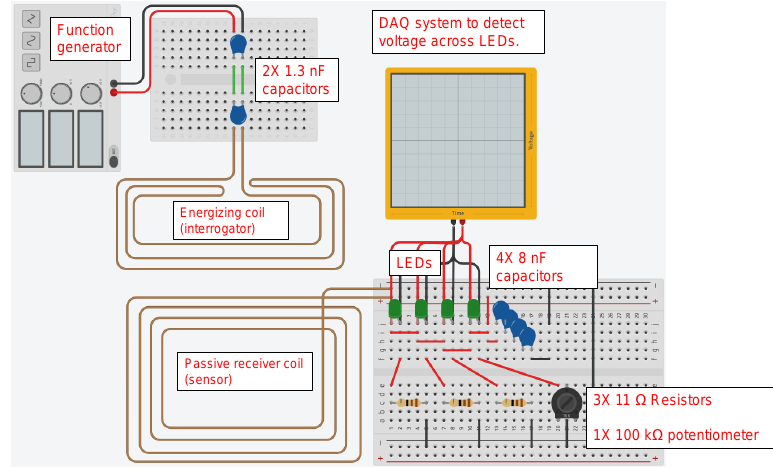
Figure 3. Diagram of experimental circuit for model validation.